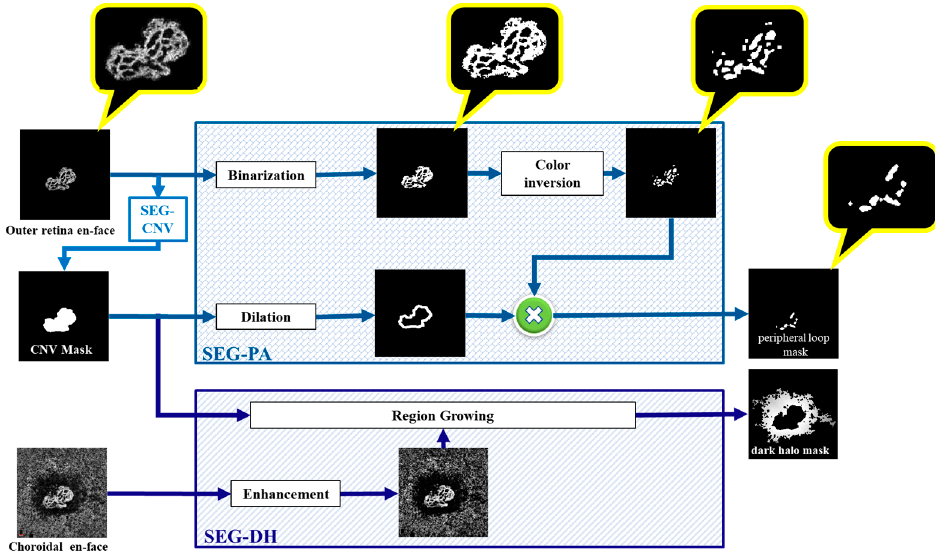
Figure 4. Proposed algorithm for SEG-PA and SEG-DH.